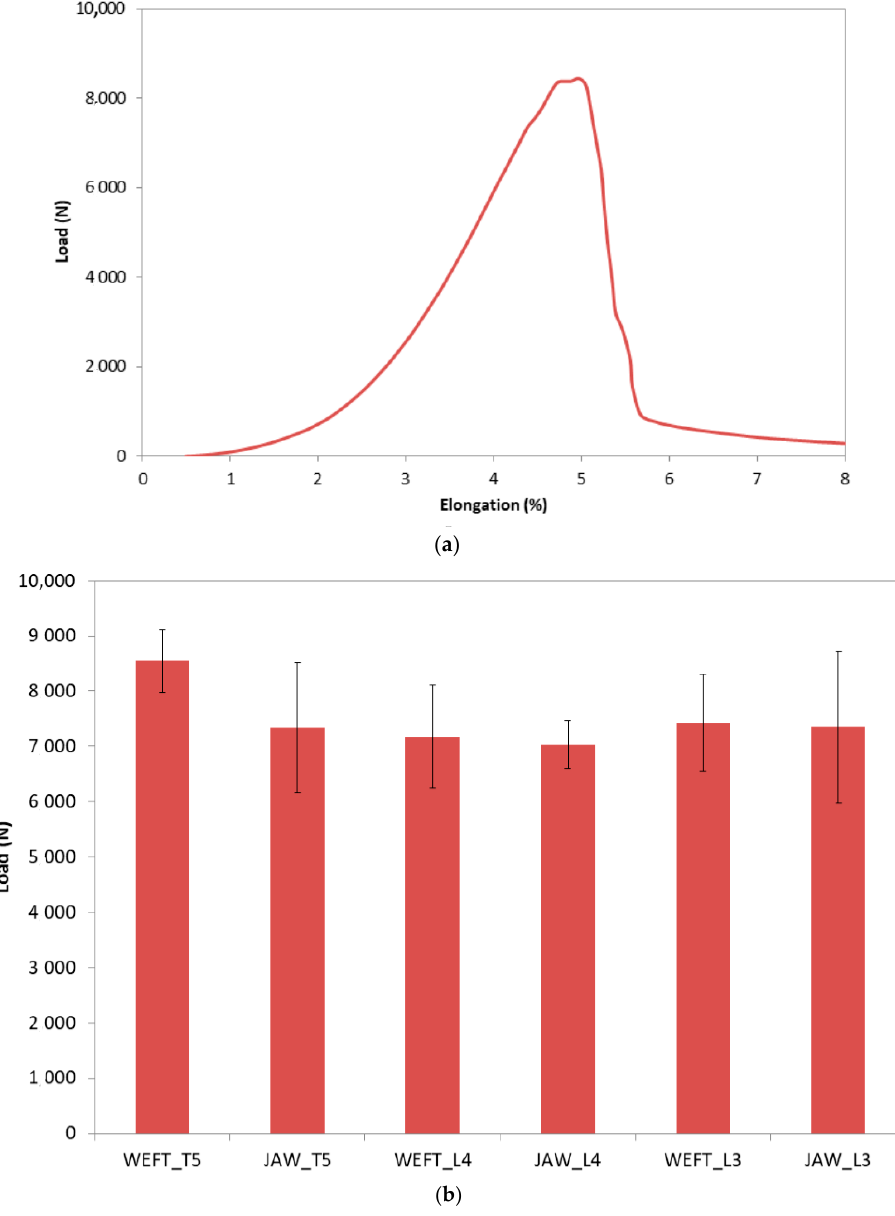
Figure 11. Tensile test in weft direction. ( a ) Example of structure WEFT_T5. ( b ) Maximum load of the six 3D warp interlock structures.